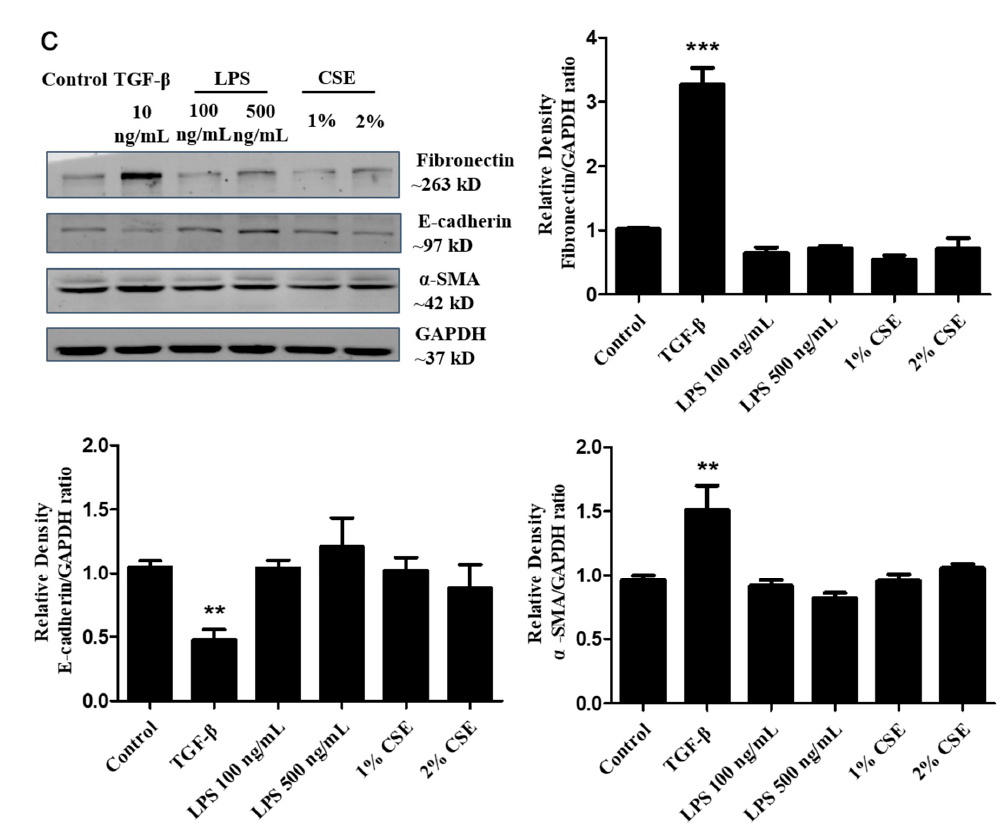
Figure 3. Changes in morphology and biomarkers in the transforming growth factor beta (TGF- β )-induced epithelial–mesenchymal transition (EMT) process of A549 cells. ( a ) Schematic treatment points of experimental design. After serum starvation for 24 h, cells were treated with TGF- β (10 ng / mL), lipopolysaccharide (LPS) (100 and 500 ng / mL), and cigarette smoke extract (CSE) (1% and 2%) for 48 h. ( b ) Representative images (original magnification 200 × ). Red arrows indicate a part of the typical cell shape (cobblestone type) in the control group, and blue arrows indicate a part of the fibroblast type of A549 cells after stimulation by TGF- β . ( c ) Representative bands and quantitative analysis of EMT markers (fibronectin, E-cadherin, and alpha smooth muscle actin ( α -SMA). The expressions were detected by Western blot. GAPDH was used as the loading control. *** p < 0.001, ** p < 0.01 vs. the control group, n = 3.